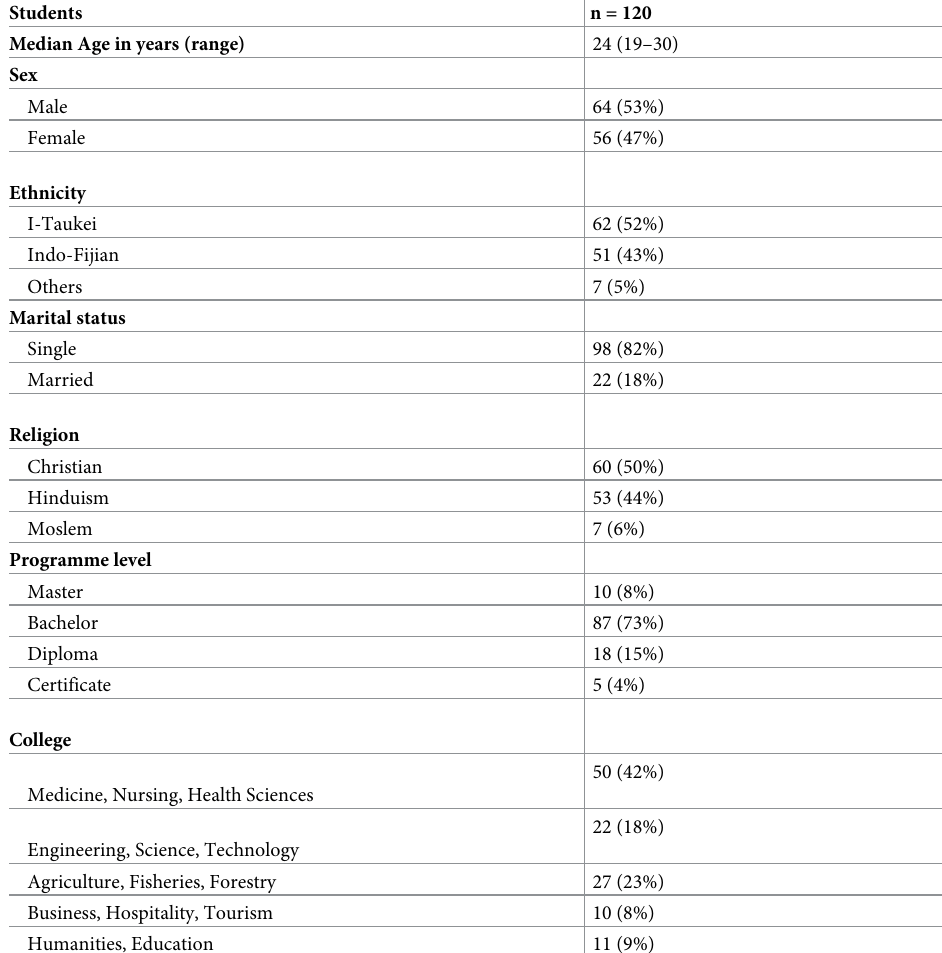
Table 1. Demographic characteristics of students